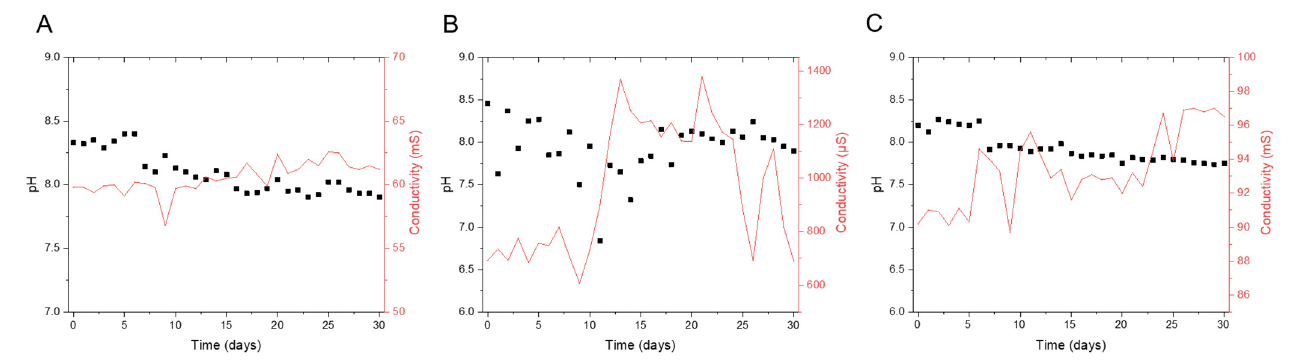
Figure 2. pH and conductivity profile of the ( A ) seawater feed, ( B ) SWRO permeate, and ( C ) SWRO brine during the 30-day pilot test study.